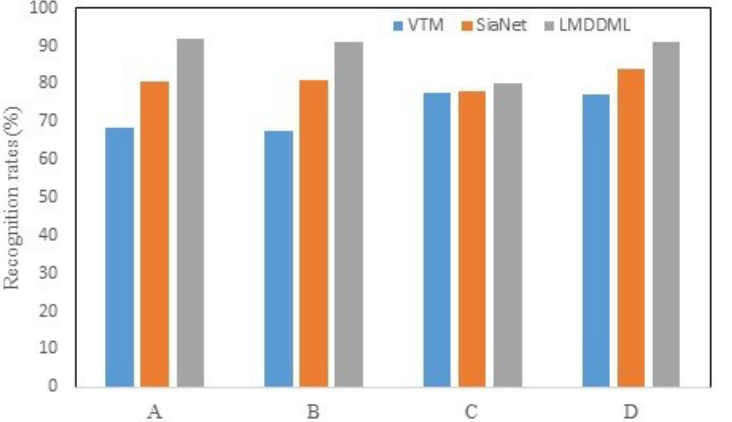
Figure 12: Comparison of the cross-view matching approaches on different groups. Group A D stand for (65,75), (75,65), (75,85), and